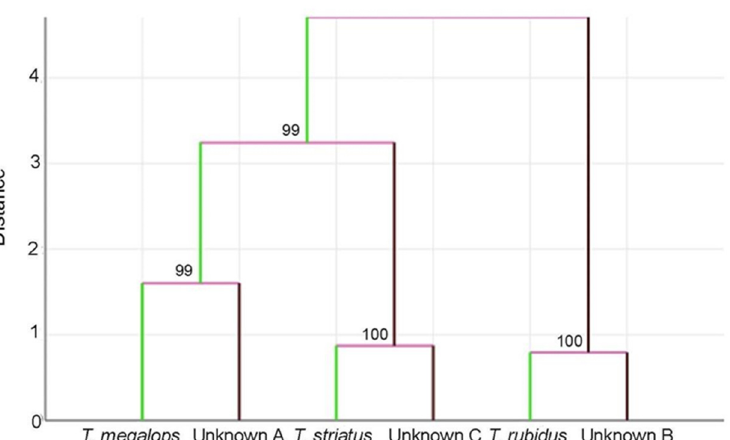
Figure 9. Hierarchical clustering tree based on shape similarities of reference data and unknown specimens. Unknown A: specimens from Chainat Province; Unknown B: specimens from Uthai Thani Province; and Unknown C: specimens from Nakhon Ratchasima Province. In this total sample classification analysis, all the specimens, including the unknown ones, helped with computing the discriminant model. The distances used for the tree construction were the Mahalanobis distances. Numbers at the nodes indicate the percentages of bootstrap values based on 1000